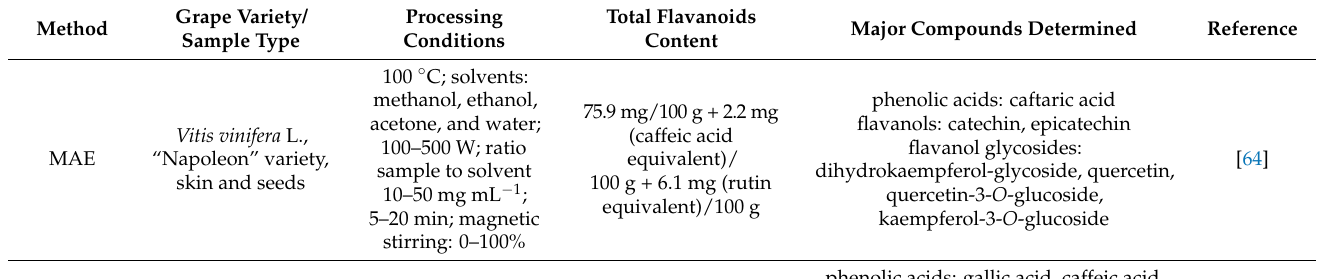
Table 2. Comparison of novel green extraction methods used for the extraction of flavonoids from grape